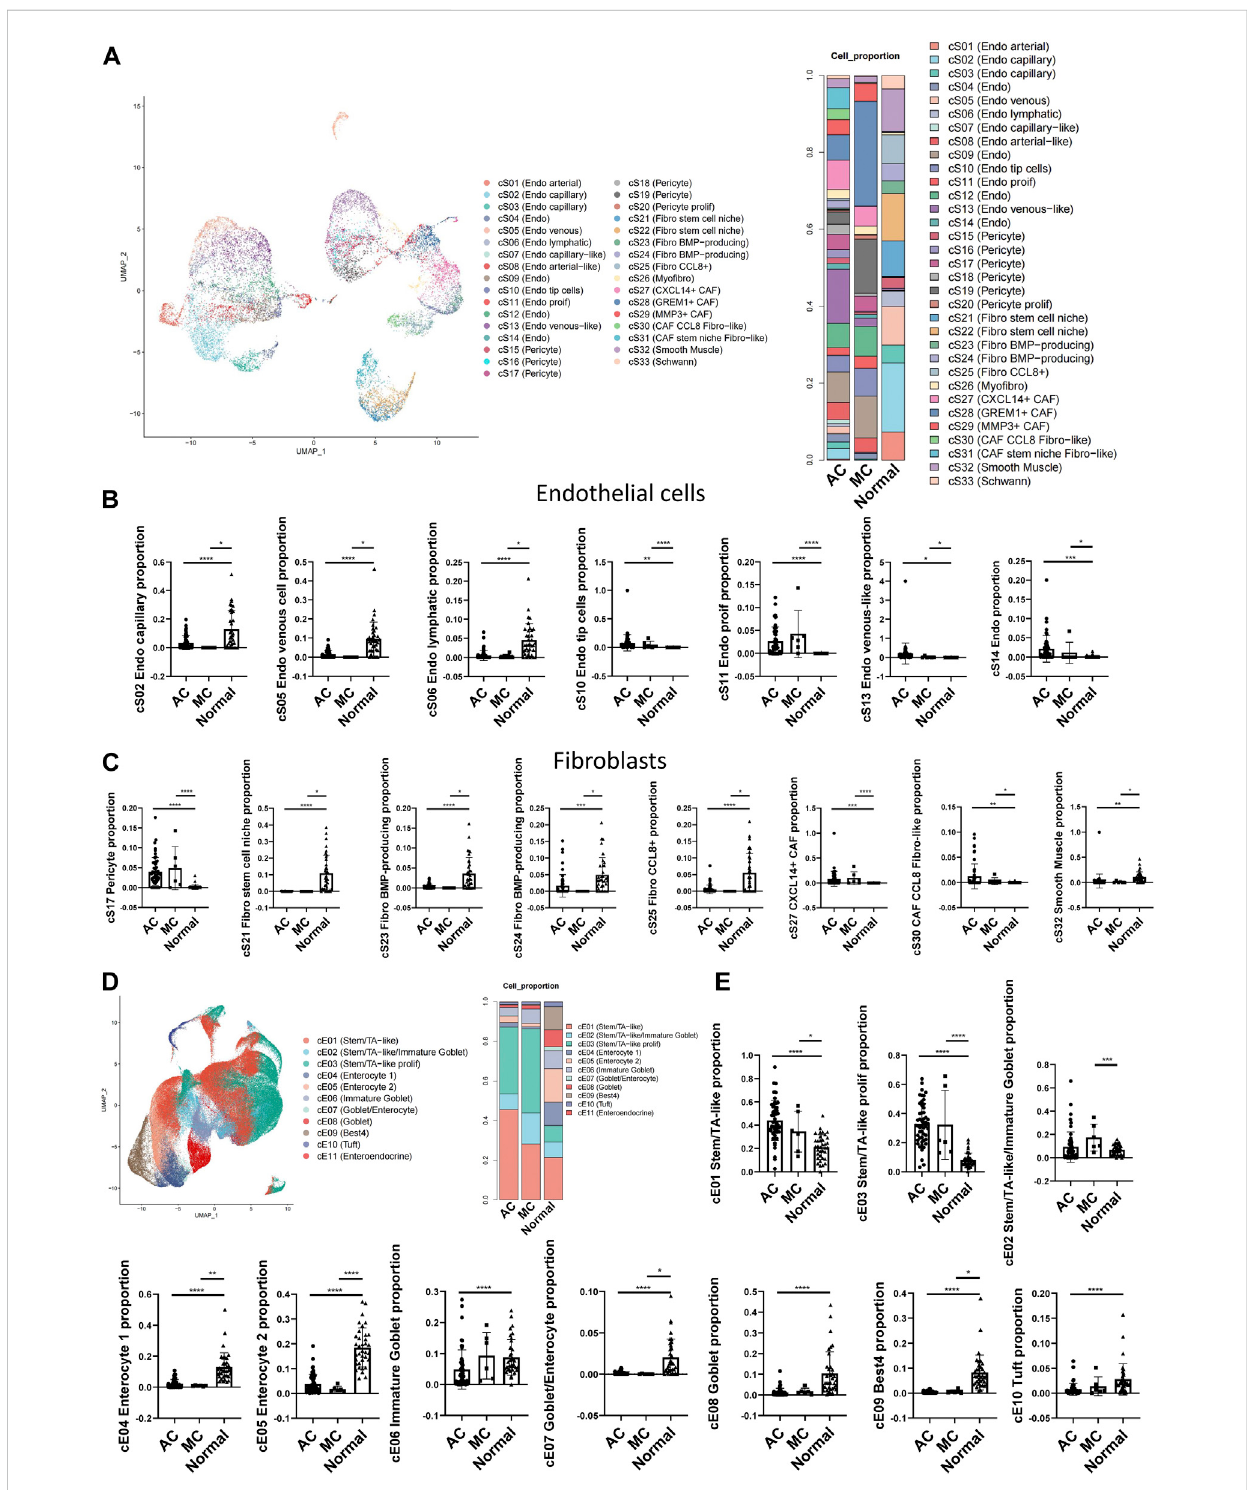
FIGURE 5 Stromal cell and epithelial cell proportions in human colorectal adenocarcinoma not otherwise speci fi ed, mucinous adenocarcinoma, and normal colon. (A) Stromal cell subcluster and proportion in human colorectal adenocarcinoma not otherwise speci fi ed, mucinous adenocarcinoma, and normal colon. (B) Bar plots showing the signi fi cance of different endothelial cell proportions in two types of colorectal adenocarcinomas and normal colon. (C) Bar plots showing the signi fi cance of different fi broblast proportions in two types of colorectal adenocarcinomas and normal colon. (D) Epithelial cell subcluster and proportion in human colorectal adenocarcinoma not otherwise speci fi ed, mucinous adenocarcinoma, and normal colon. (E) Bar plots showing the signi fi cance of different epithelial cell proportions in two types of colorectal adenocarcinomas and normal